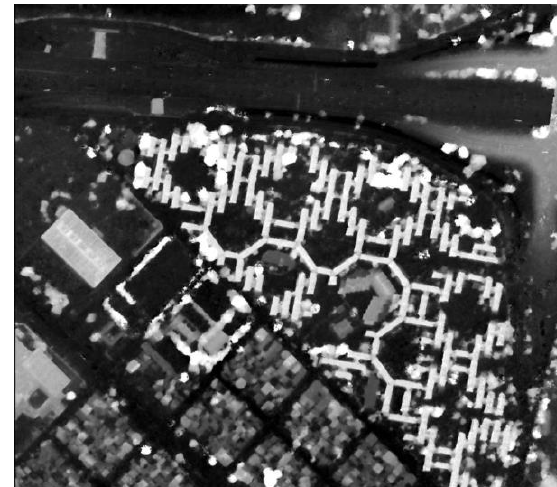
Figure 7. Relation between the completeness and the number of fused stereo image pairs